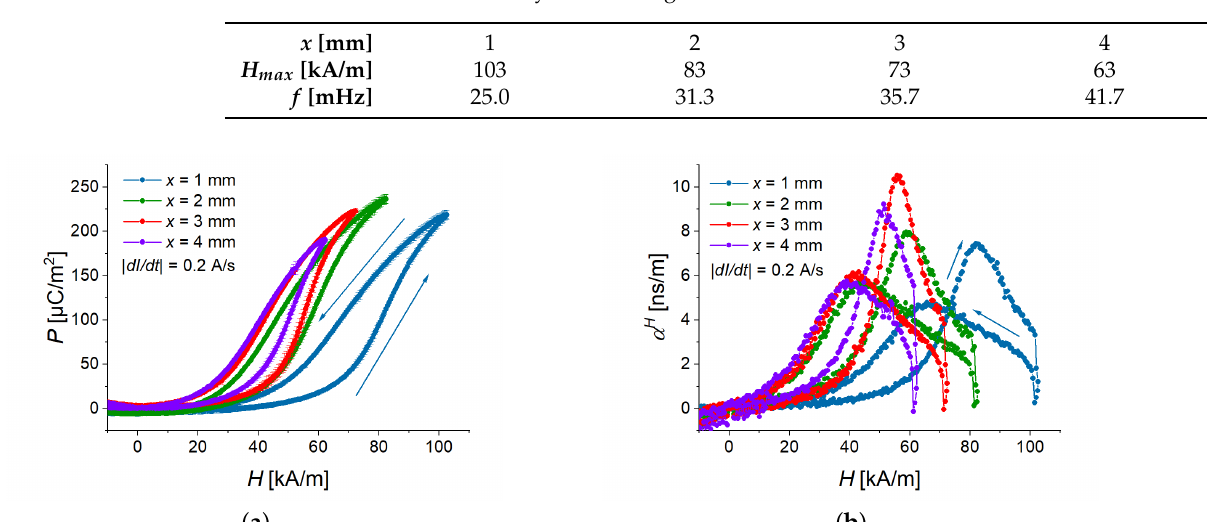
Table 2. Amplitudes of triangle-wave magnetic fields and their corresponding frequencies for different thicknesses of MAE layer at the magnetic slew rate of 12.2 kA/sm.